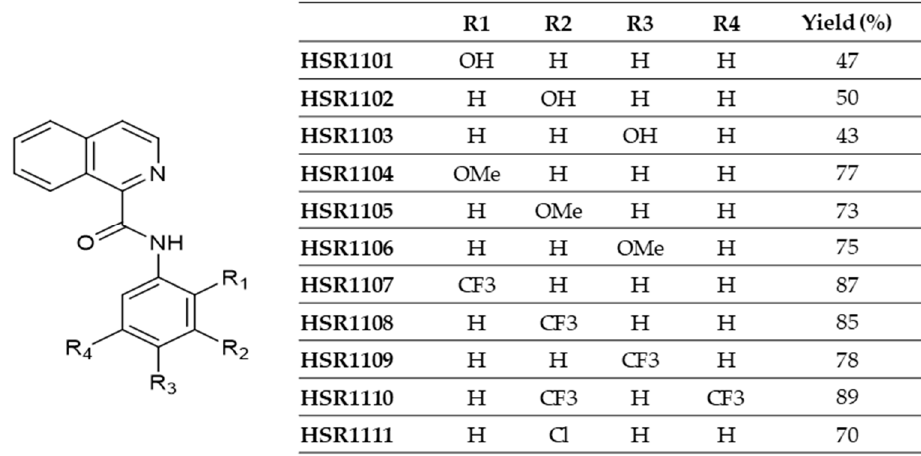
Figure 1. Chemical structures and yield of isoquinoline-1-carboxamide derivatives.